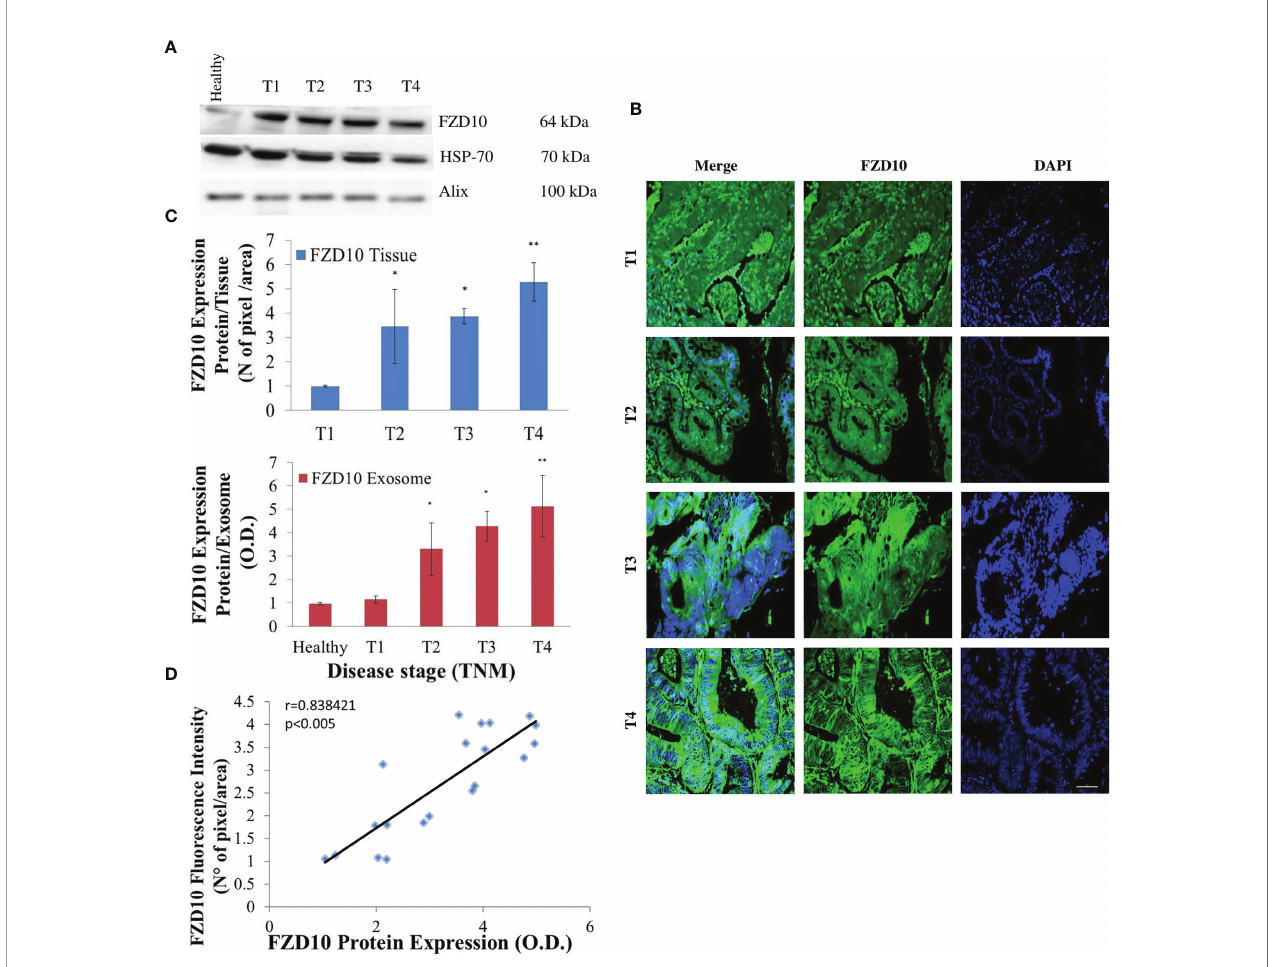
FIGURE 2 | Evaluation of Frizzled (FZD)10 in exosomes isolated from plasma and corresponding tissue samples derived from (20) gastric cancer (GC) patients at different TNM stages. Representative Western blotting of FZD10 and the two marker proteins (HSP-70 and ALIX) in exosomes derived from (20) healthy donors and GC patients (A) . Representative confocal microscopy images of tissues for the immuno fl uorescence detection of FZD10. Blue channel: nuclei; green channel: labeled FZD10 and corresponding overlay. Scale bar, 50 µm. Magni fi cation, ×20 (B) . Semiquantitative evaluation of FZD10 expression level in exosomes extracted from healthy donors and GC patients by video-densitometry analysis of FZD10 bands on Western blotting. The HSP-70 protein band was used for the normalization of the FZD10 band for each subject. (*) p < 0.005 and (**) p < 0.001 vs . healthy donors (red bars). FZD10 expression level, quantitatively evaluated as mean green fl uorescence intensity index, in tissues by immuno fl uorescence (blue bars). (**) p < 0.001 vs . GC patients with stage T1 (C) . Pearson ’ s correlation between FZD10 expression levels in exosomes by Western blotting analysis and the corresponding tissues by immuno fl uorescence analysis for each subject. p < 0.005 (D)